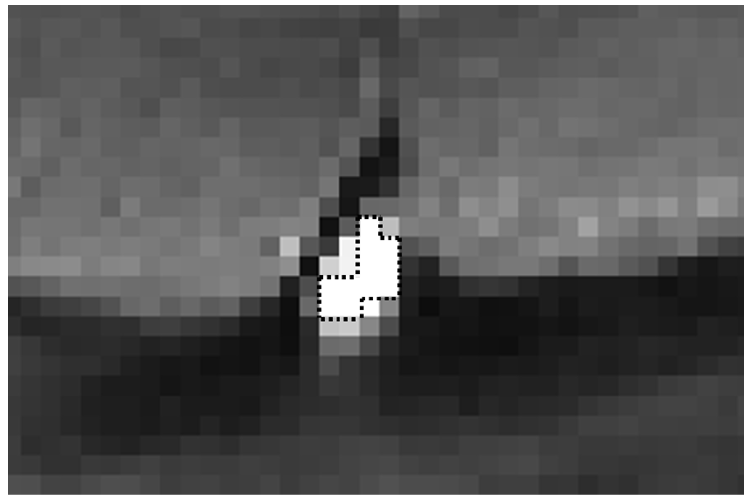
Figure 1. Enlarged view of the superior sagittal sinus of a SE-EPI image. The black dotted line represents the ROI (11 pixels) for the signal measurement in the superior sagittal sinus.